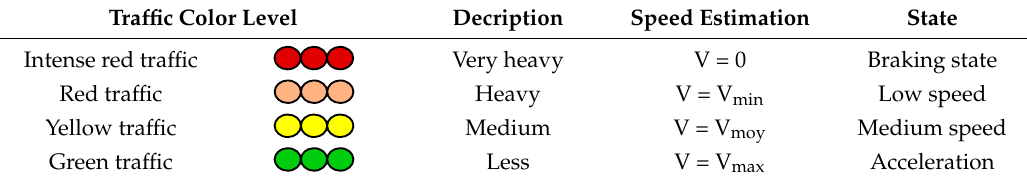
Table 1. Speed estimation.